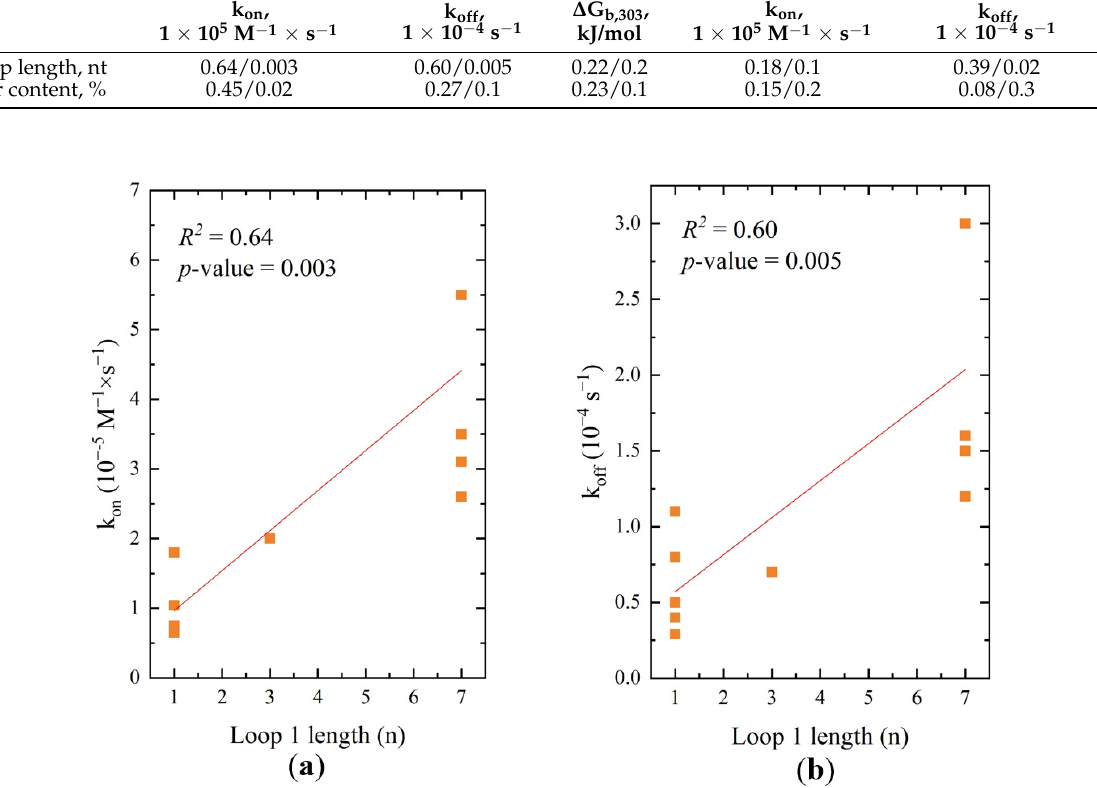
Figure 5. The plots of rate constants ( a ) association rate constants, ( b ) dissociation rate constants versus the aptamer’s loop length for complexes aptamer–rHA.